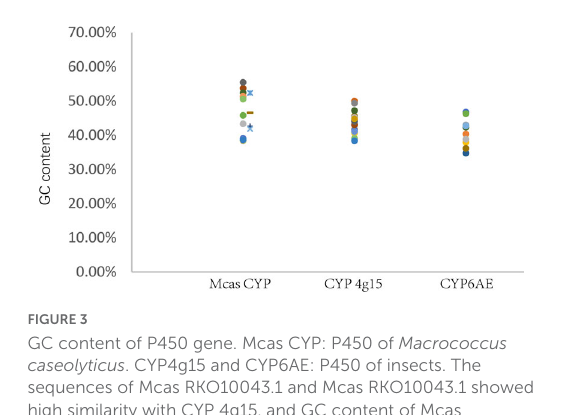
FIGURE3 GC content of P450 gene. Mcas CYP: P450 of Macrococcus caseolyticus . CYP4g15 and CYP6AE: P450 of insects. The sequences of Mcas RKO10043.1 and Mcas RKO10043.1 showed high similarity with CYP 4g15, and GC content of Mcas RKO10043 was higher than the maximum GC content of CYP4g15 of insects; the sequences of Mcas RKO09869.1 and Mcas RKO10218.1 showed high similarity with CYP